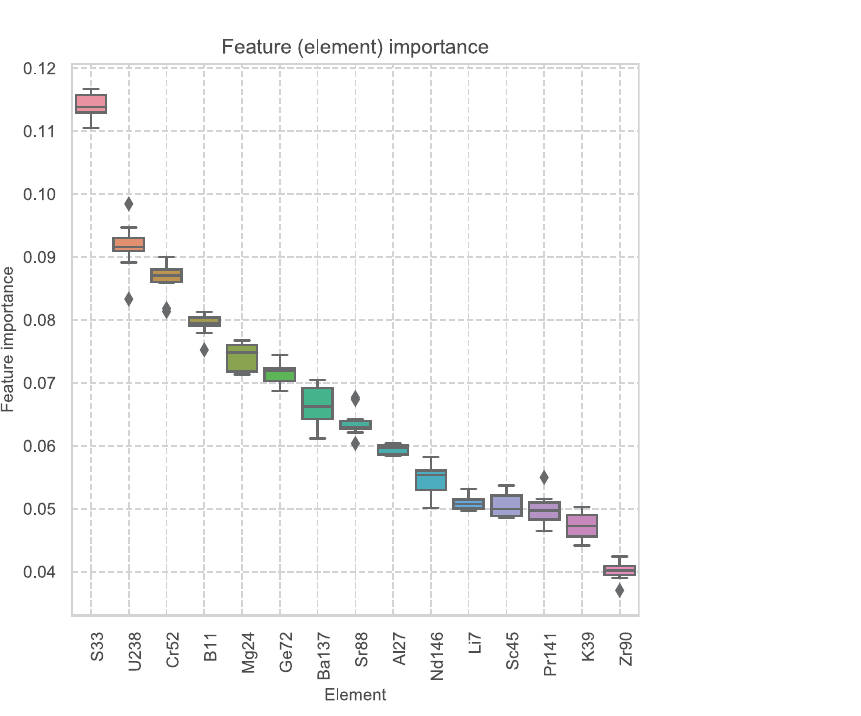
Figure 4. Feature importance results from